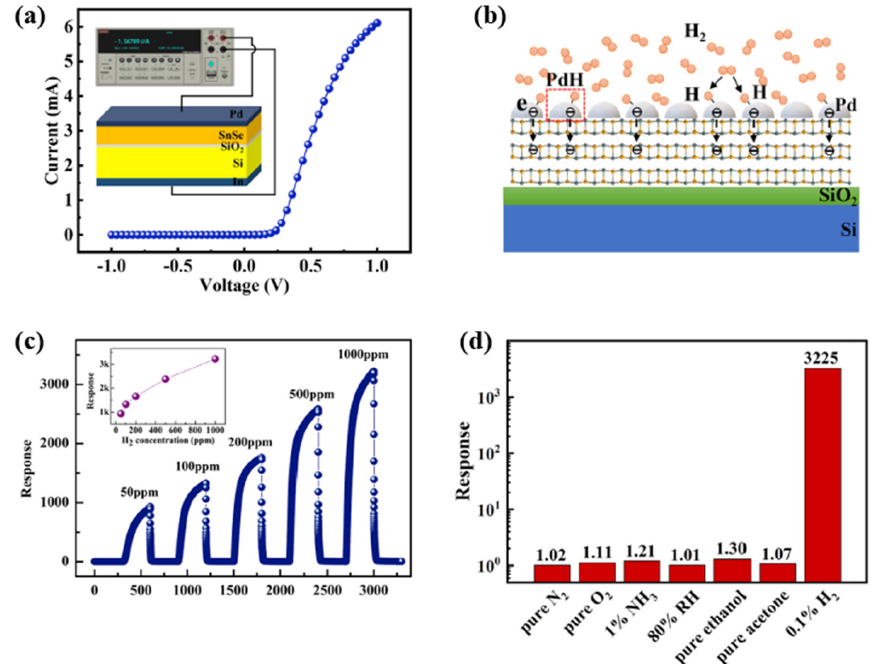
Figure 9. ( a ) The I–V curve of a SnSe/SiO 2 /Si heterojunction. The inset shows a schematic illustration of the measurements. ( b ) Schematic illustration of the sensing behaviour of the Pd-decorated SnSe/SiO 2 /Si heterojunction towards H 2 . ( c ) The consecutive dynamic response of the heterojunction upon exposure to the above concentrations of H 2 . The inset shows the dependence of the response on the H 2 concentration. ( d ) The sensor’s response to pure N 2 , O 2 , ethanol and acetone, 10,000 ppm NH 3 , 80% relative humidity (RH) (H 2 O) and 1000 ppm H 2 [61]. Copyright (2021), with permission from Elsevier.